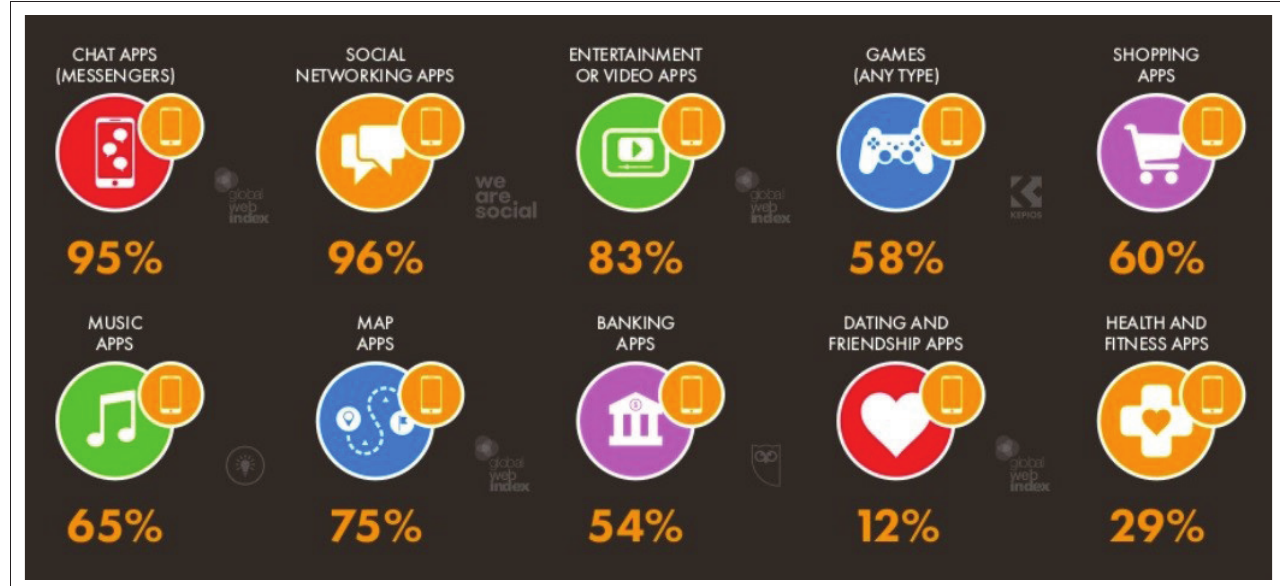
FIGURE 3: Use of mobile apps by category in South Africa, January